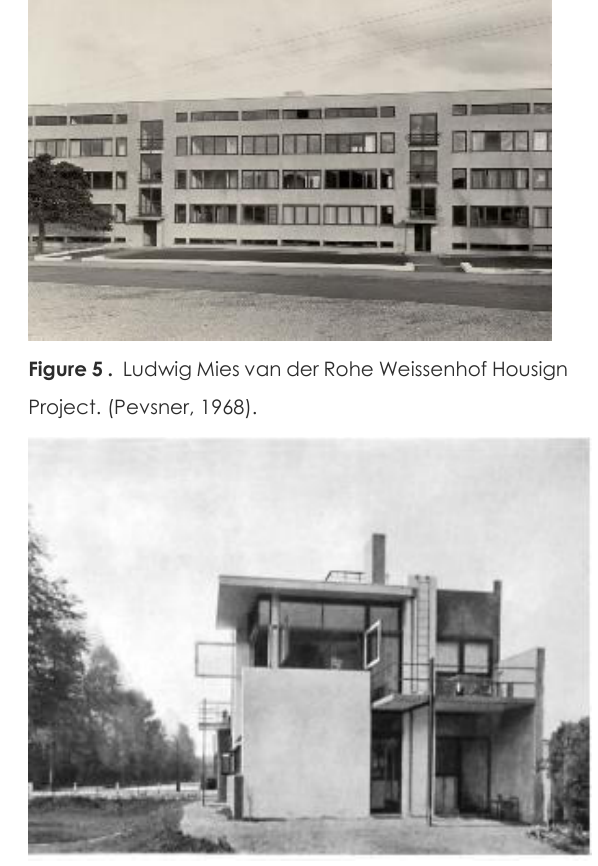
Figure 6. Garrit Rietveld, Schr¨oder House, Utrecht, 1924– 5. (Pevsner, 1968).